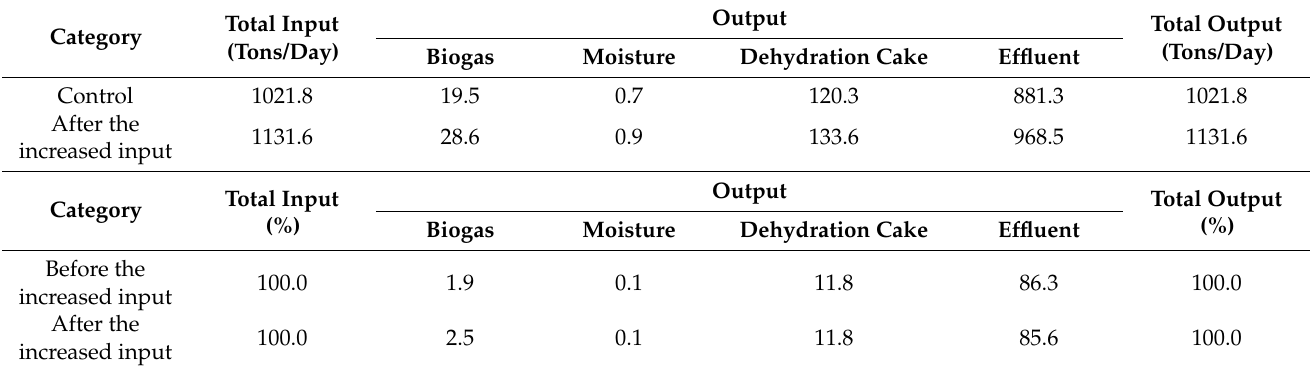
Table 6. Calculation of dehydration cakes and influent of the wastewater treatment plant.